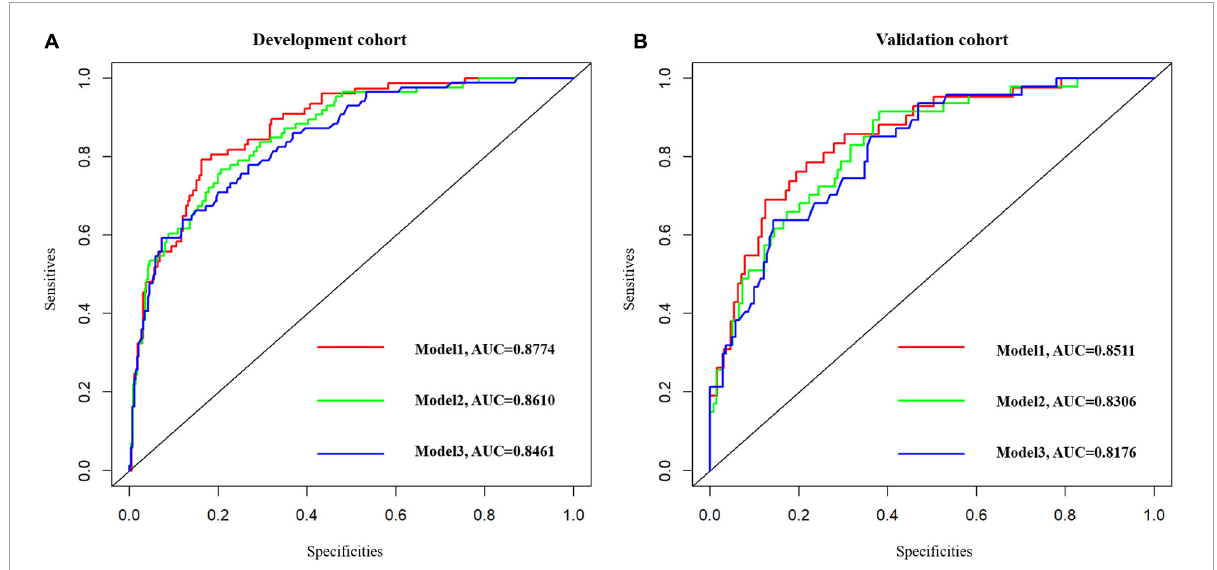
FIGURE2 The ROC curves of the three models. Model 1: NIHSS + Age + AST + TP + ALB + NLR + fT3 + FI. Model 2: NIHSS + Age + Hepatic function parameters (AST, TP). Model 3: NIHSS + Age. (A) Model 1 vs. model 2, Z = 0.1756, p -value = 0.8607. (B) Model 1 vs. model 2, Z = 1.4837, p -value = 0.1379. ROC, receiver operating characteristic.